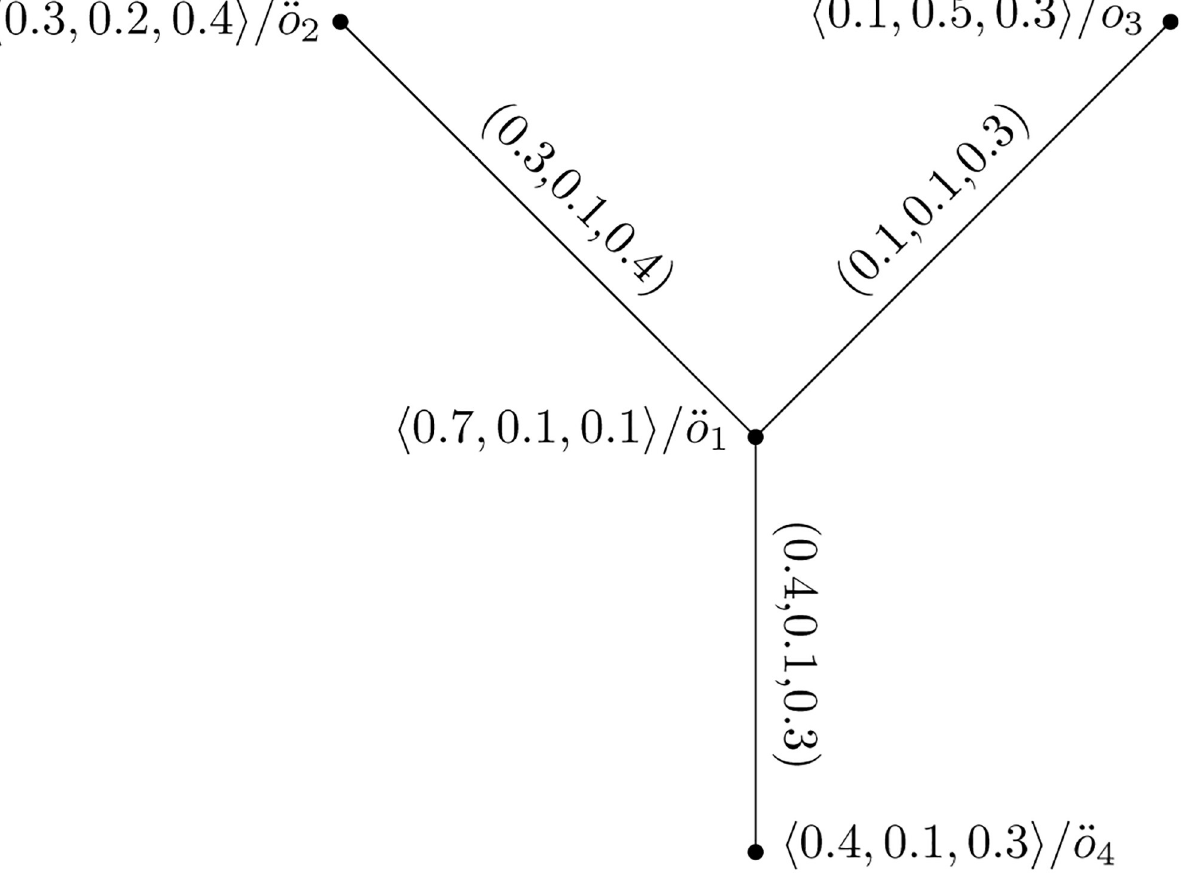
¼ ð € H ð € t Þ ; € G ð € t ÞÞ . 1 1 1